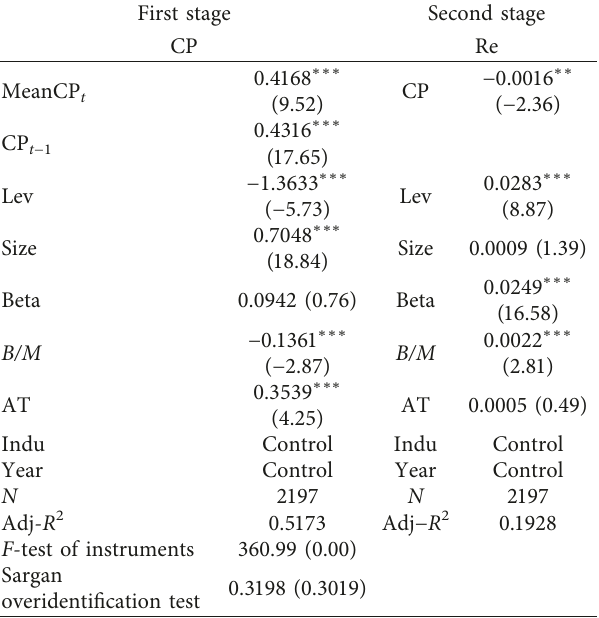
Table 7: 2SLS regression test. First stage Second